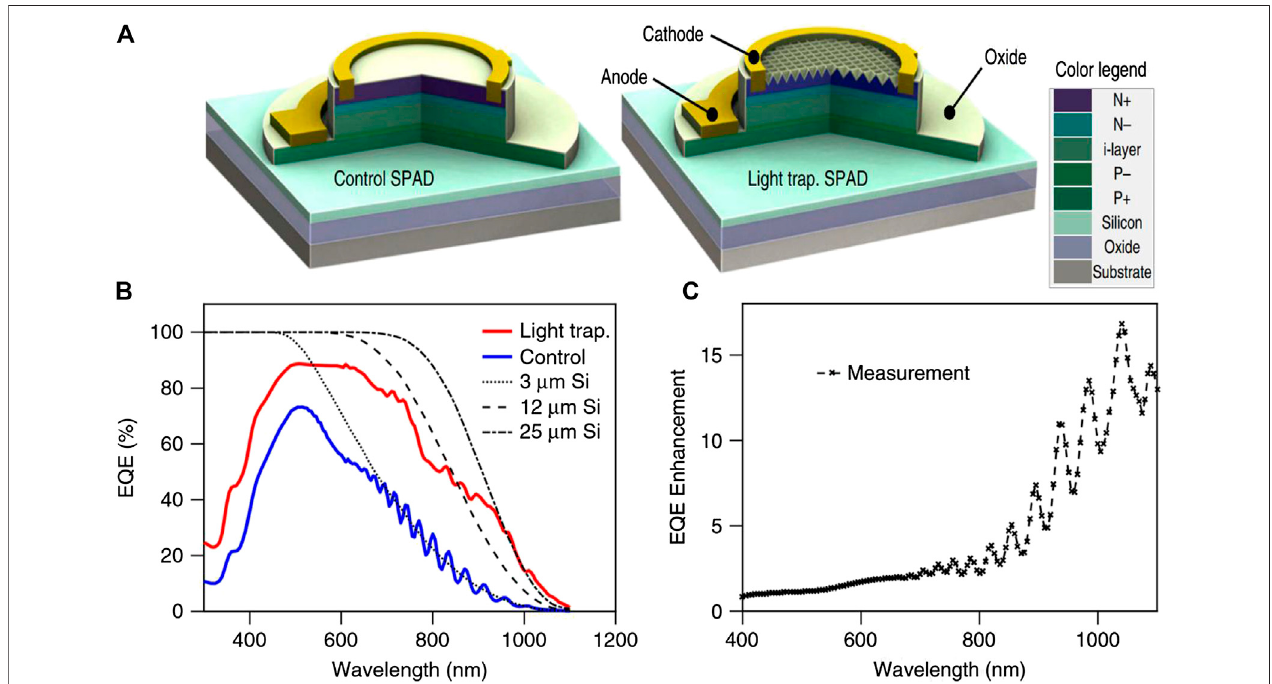
FIGURE 2 | (A) Three-dimensional (3D) cross-sectional schematics of layer con fi gurations of control (left) and light-trapping SPADs (right) . (B) EQE measurementsofcontrol(bluesolid)andlight-trappingSPADs(redsolid);dashedblacklinescorrespondtotheoreticalabsorptionof3,12,and25 μ mthickSifromleftto right. (C) EQE enhancement: ratio of light-trapping SPAD EQE compared to control SPAD. Source : Reproduced from Ref. 13.